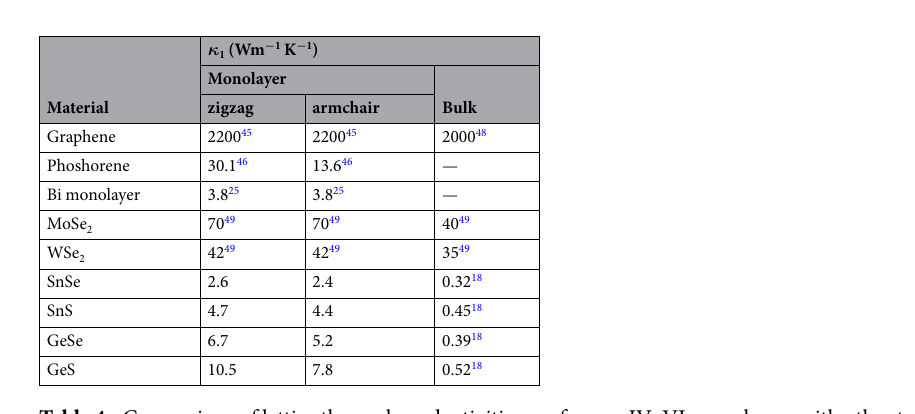
Table 4. Comparison of lattice thermal conductivities κ l of group IV–VI monolayers with other two- dimensional materials at room